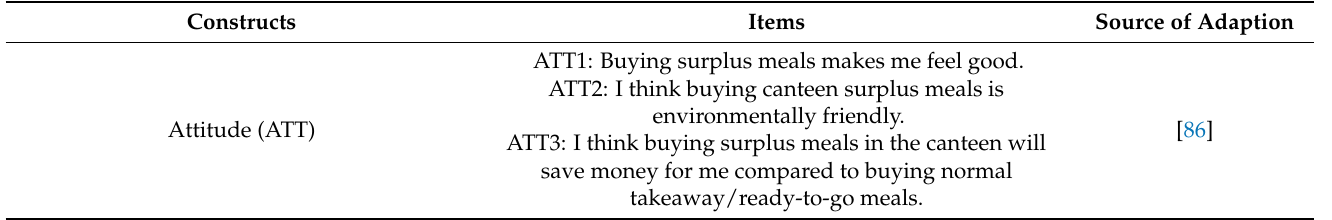
Table 1. Items measuring the constructs of the proposed TRA-extended model and MFRL instrument. Constructs Items Source of Adaption ATT1: Buying surplus meals makes me feel good. ATT2: I think buying canteen surplus meals Attitude (ATT)